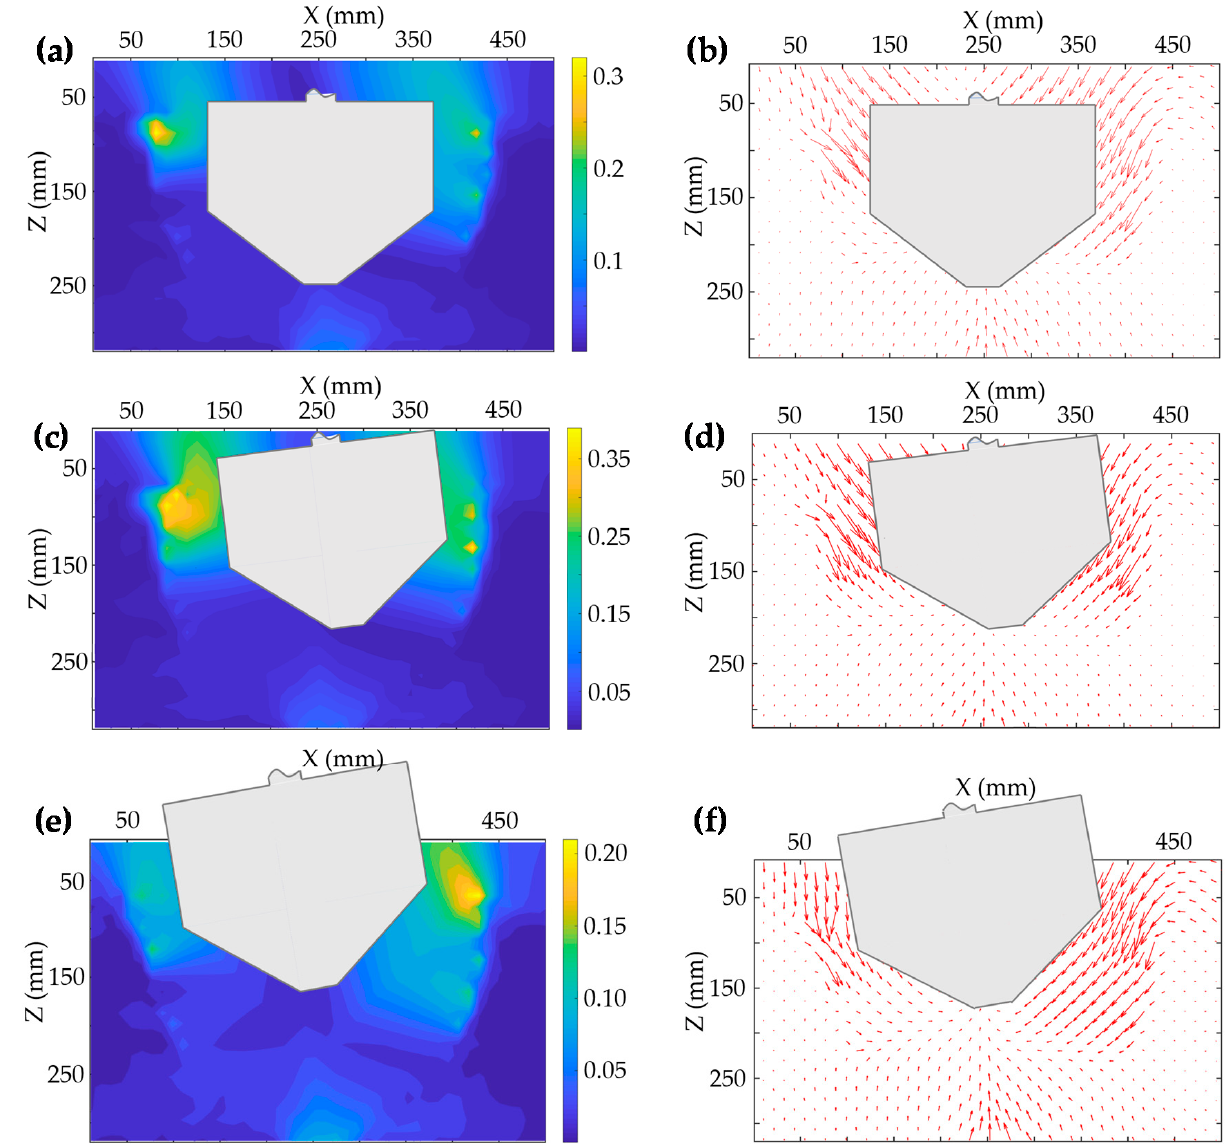
Figure 8. The displacement cloud diagrams and displacement vector diagrams of loose sands: ( a ) displacement cloud diagram in floating stage; ( b ) displacement vector diagram in floating stage; ( c ) displacement cloud diagram in inclined stage; ( d ) displacement vector diagram in inclined stage; ( e ) displacement cloud diagram in unstable failure stage; ( f ) displacement vector diagram in unstable failure stage.